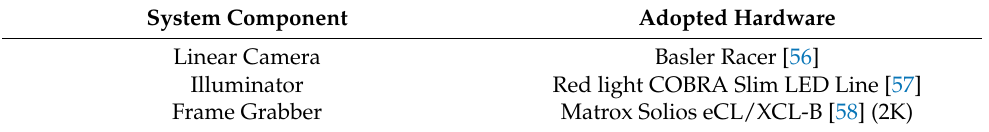
Table 1. Image acquisition